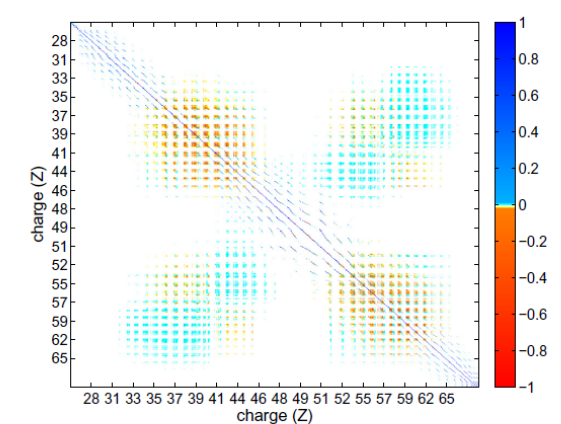
Fig. 9. Correlation matrix of cumulated yields proposed by L. Fiorito et al. [6,